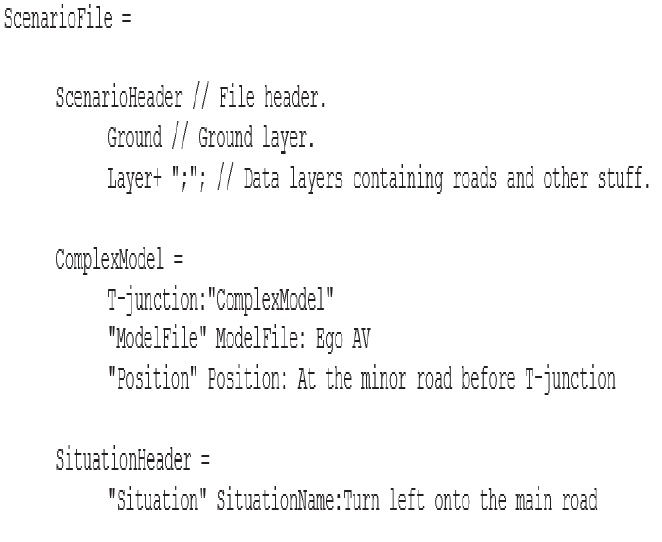
Figure 6. Hesperia description of T-junction